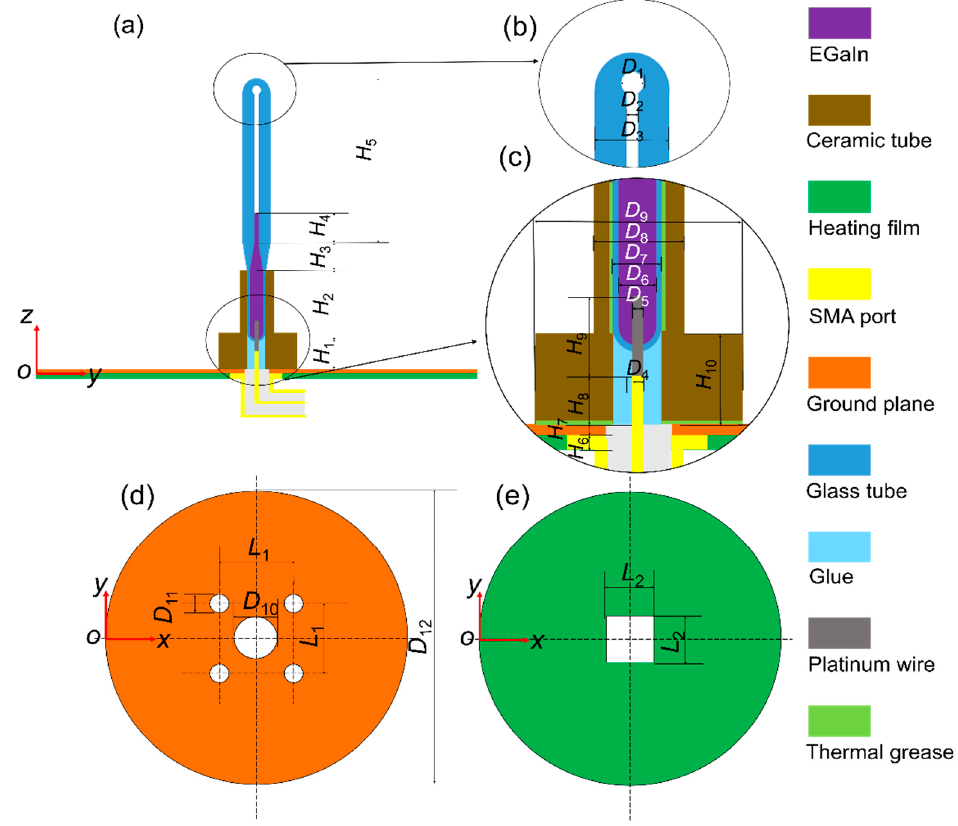
Figure 1. Configuration of the proposed monopole antenna. ( a ) Front view. ( b ) Top zoom. ( c ) Bottom zoom. ( d ) Ground plane. ( e ) Heating film.